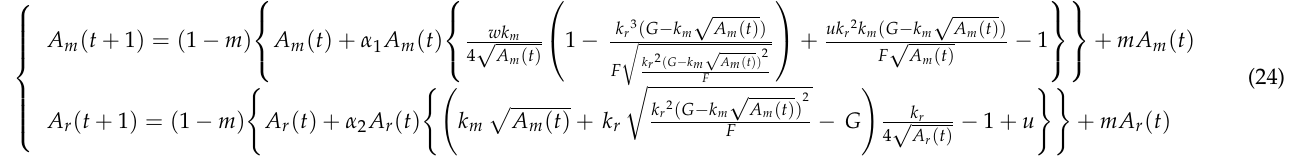
Figure 3. By m = 0.1, 0.2, 0.3, 0.4, the stable region expands with an increase in parameter m . Nevertheless, the Nash equilibrium ( A m , A r ) does not change with parameter m and stays at ( 407.2, 162.8 )